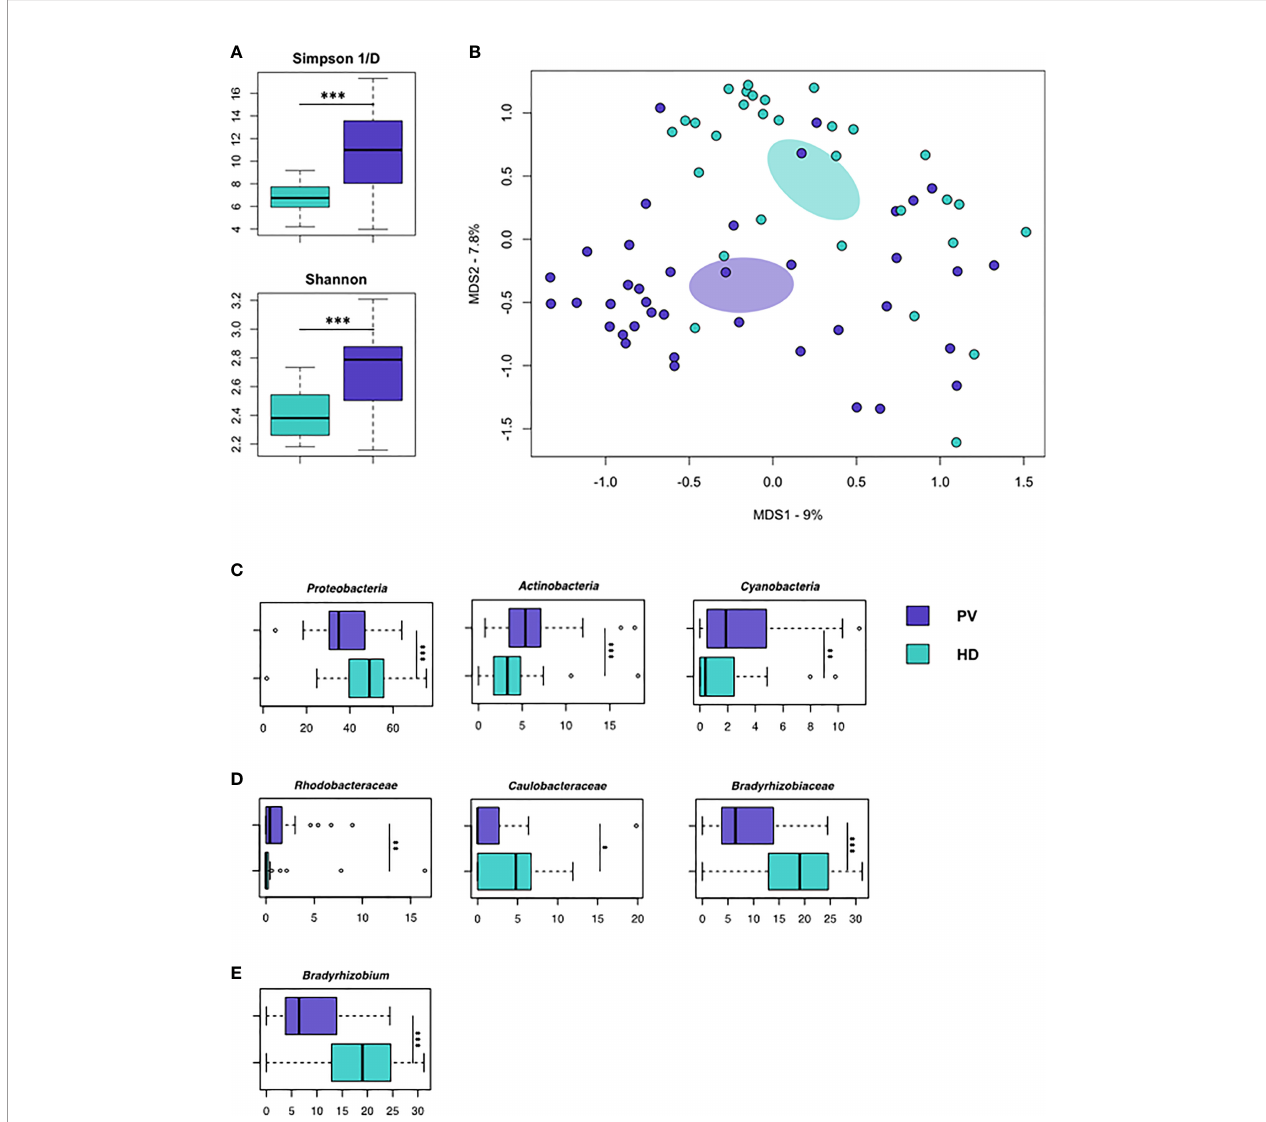
FIGURE 2 | Microbial DNA cargo of isolated EVs in PV patients and HD. (A) Alpha diversity estimated according to inverse Simpson (top) and Shannon (bottom) indices. PV patients show signi fi cantly higher biodiversity than HD (p < 0.001, Wilcoxon rank-sum test). (B) Principal Coordinates Analysis (PCoA) based on Jaccard similarity between the genus-level pro fi les of EVs from PV patients and HD. Signi fi cant segregation between groups was found (p = 0.001, permutation test with pseudo- F ratio). (C – E) Boxplots showing the relative abundance distribution of phyla, families and genera that were signi fi cantly differentially represented between HD and PV patients (*p < 0.05; **p < 0.01; ***p < 0.001; Wilcoxon rank-sum test). Only bacterial taxa with mean relative abundance ≥ 1% in at least one of the comparison groups are